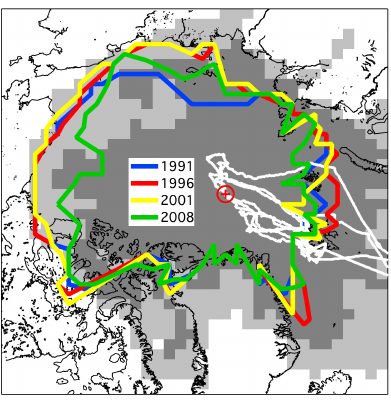
Figure 2. Map of the working area of the present study: white shows cruise tracks during the four Oden expeditions in 1991, 1996, 2001, and 2008. Red symbol: North Pole. Dark grey geocells: area cov- ered with at least 100 trajectory hits per geocell by 5-day back tra- jectories in all four cruises. Additional geocells in light grey are covered likewise by 10-day back trajectories. Colored lines: 10% limit of sea ice cover north of 76 ◦ N estimated from average sea concentrations (https://nsidc.org/data) during each of the four Oden